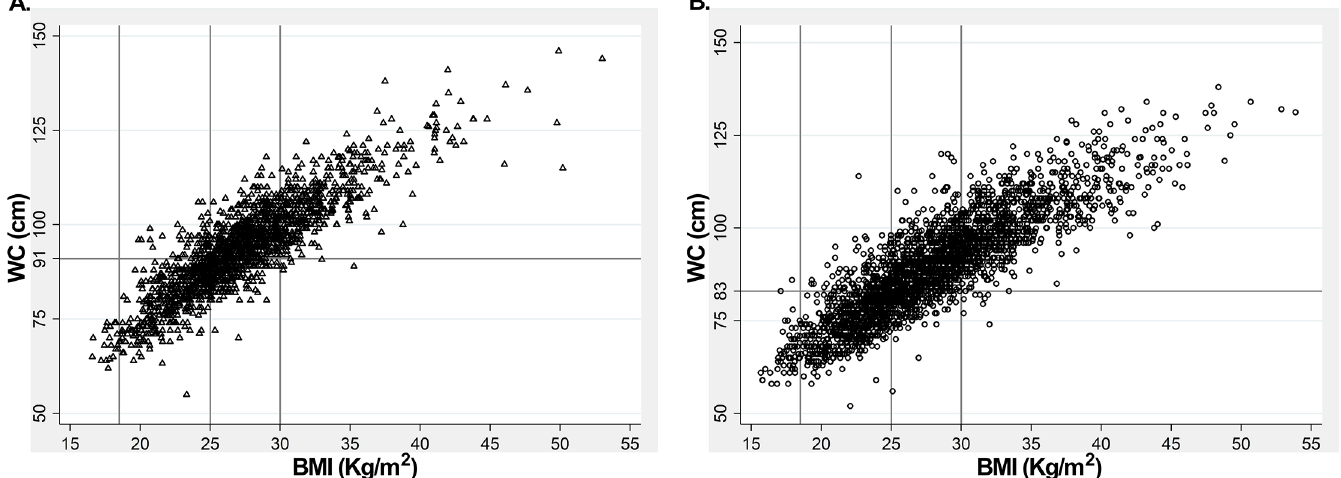
Fig 3. Correlation between BMI and WC in adults from ENS-Chile 2009–2010. Anthropometric values were measured in a total of 2132 men (A) and 3116 women (B). Vertical lines indicate the BMI values defining normal weight (18.5–24.9 kg/m 2 ), overweight (25–29.9 kg/m 2 ) and obesity ( (cid:21) 30 kg/m 2 ). Horizontal lines indicate the WC cutoff defining AO in men (91 cm) and women (83